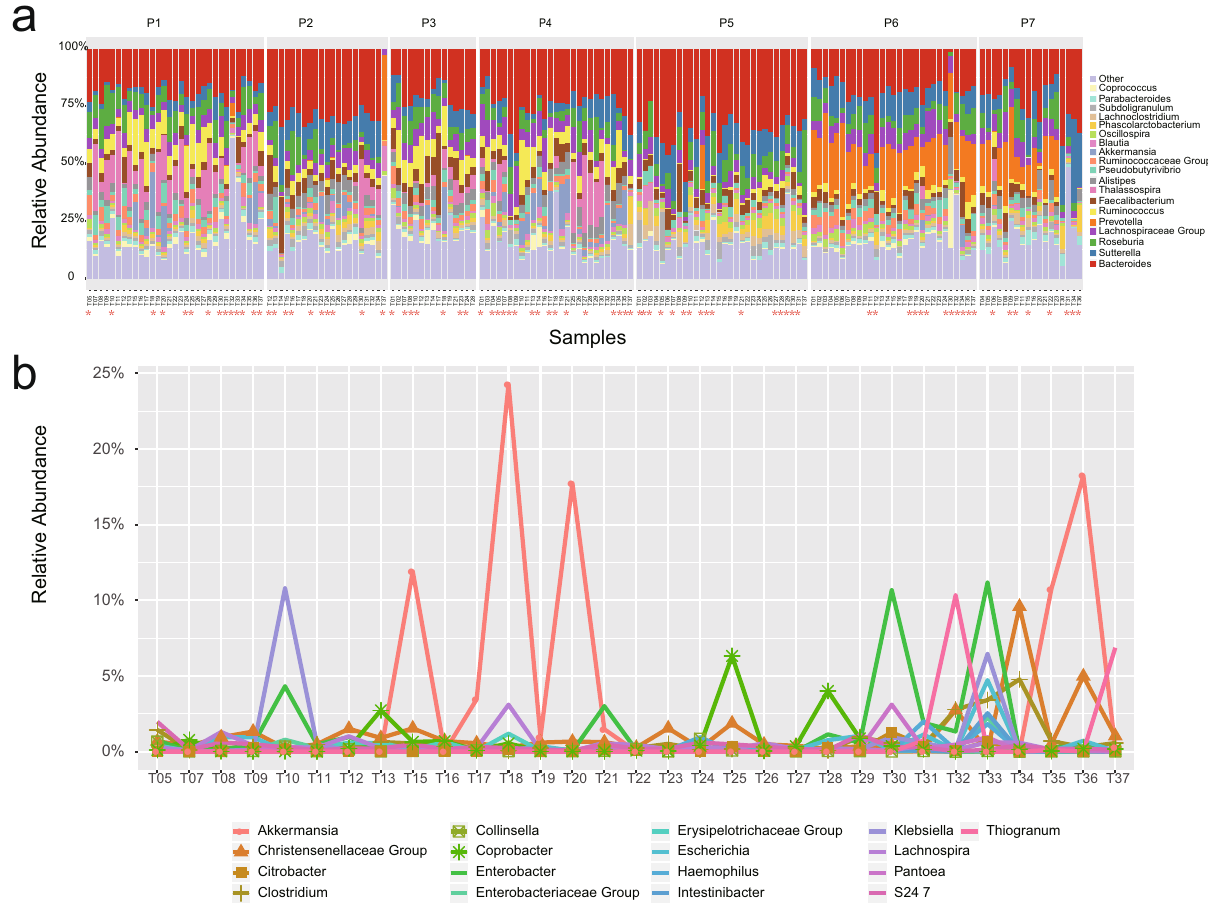
Fig. 1 Bacterial abundance in individuals with time. a Percentage of different bacterial genera in fecal samples from seven participants at different time points between 2016 and 2020. Only taxa with abundance ≥ 0.1% are shown. “ T ” on the x -axis represents the sample time point and the detailed information for these time points is listed in Supplementary Data 1. * on the x axis represents a short time bloom of particular microbes at this time point at the genus level. b The line charts for the short-term blooms of particular microbes in samples from individual P1.T, time point (Supplementary Data